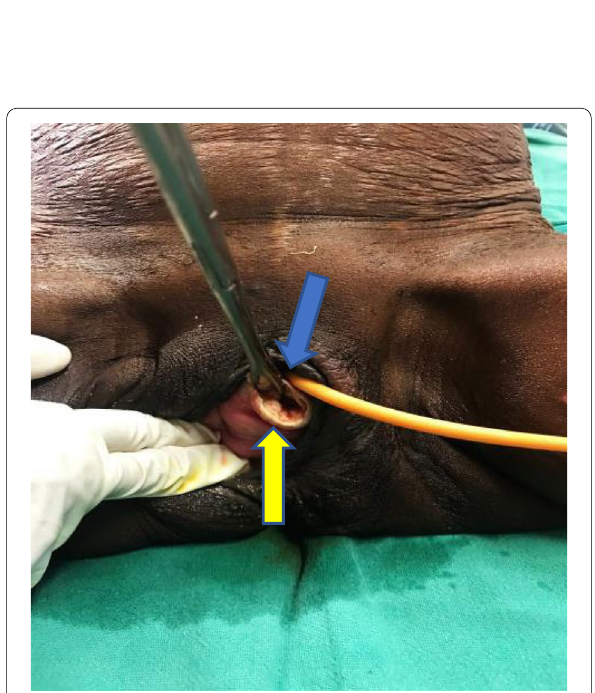
Fig. 3 Local examination of vaginoperitoneal fistula (blue arrow depicts that cervix is located anterior to the fistula. Yellow arrow shows rent in posterior vaginal wall 3